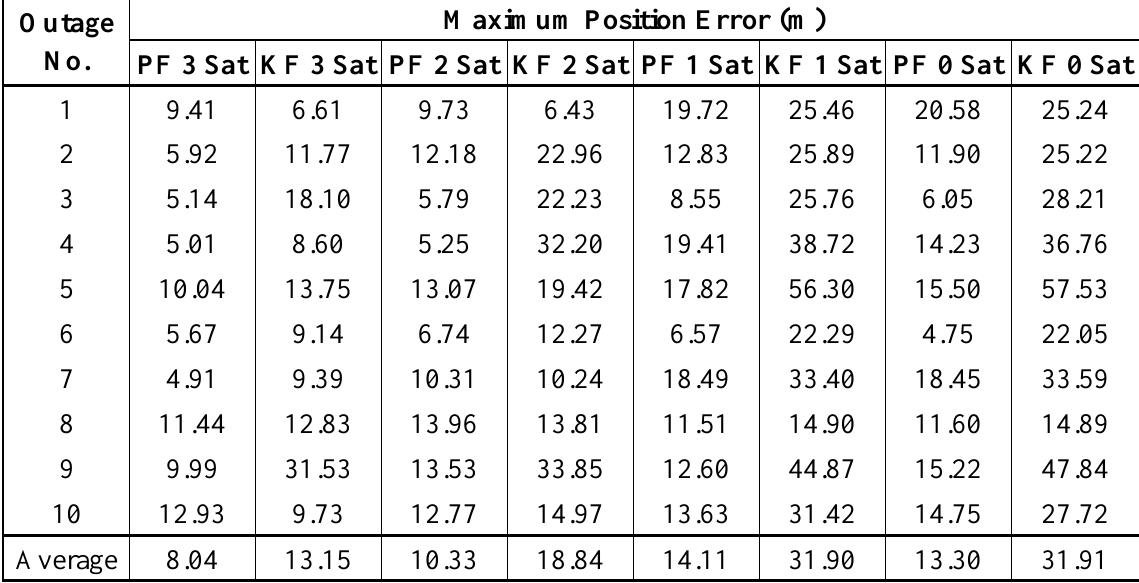
Table 2. Maximum position error during the 10 simulated outages for different numbers of visible satellites for the first